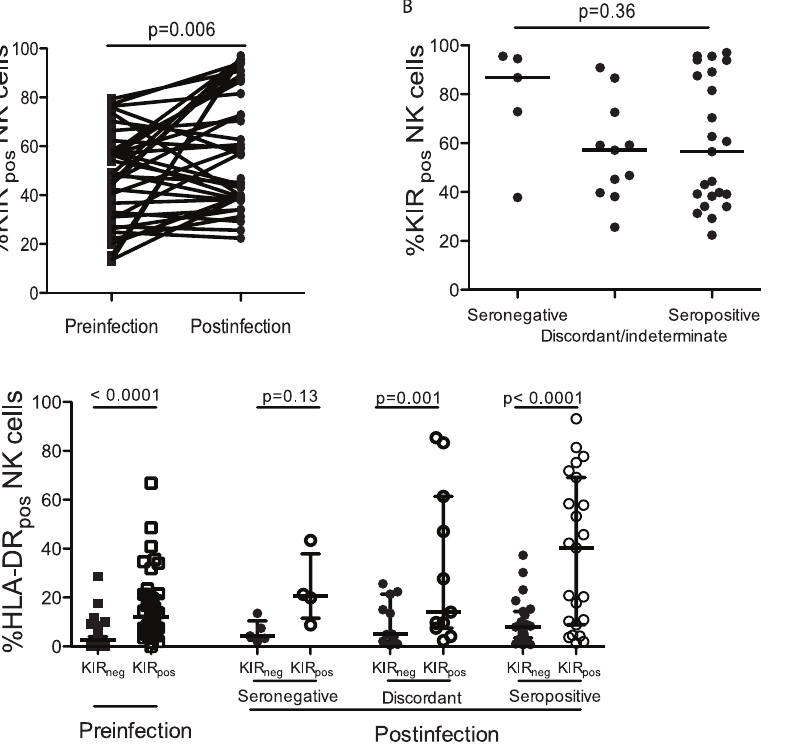
Figure 2. Following infection, an increased proportion of activated NK cells in blood expressed Killer Immunoglobulin-like Receptors (KIR). The proportion of KIR pos NK cells in blood increased following HIV infection (A). The proportion of KIR pos NK cells did not differ between stages of primary HIV infection (seronegative, sero-discordant or seropositive stages) (B). KIR pos NK cells were more activated than KIR neg NK cells (C).